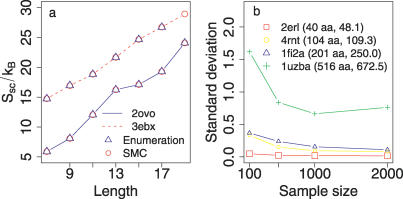
Performance of the Sequential Monte Carlo Method(A) Comparison of the SMC estimation with exhaustive enumeration for fragments of proteins 2ovo and 3ebx.(B) Standard deviation of the SMC estimation for four different sample sizes, 100, 500, 1,000, and 2,000, respectively, calculated from 20 independent SMC runs. The first number in each parentheses pair is the number of residues of the protein, and the second number the average SCE of 20 runs with 1,000 samples in each run.